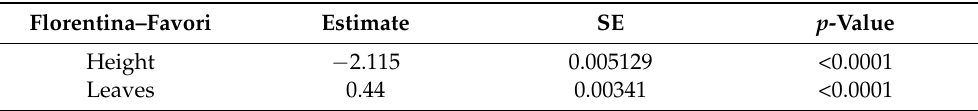
Table A7. Tukey’s pairwise comparison of least squared means for multiple comparison between the cultivars ‘Florentina’ and ‘Favori’ for plant height (cm) and number of leaves over the course of the 14 weeks treatment